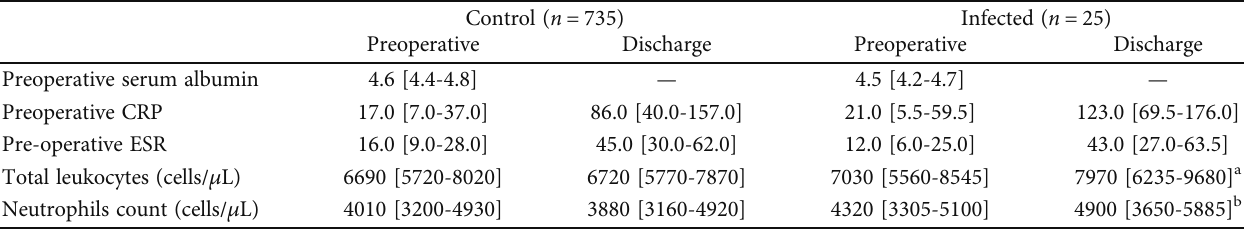
Table 2: Laboratory parameters measured before the surgical procedure and at discharge.